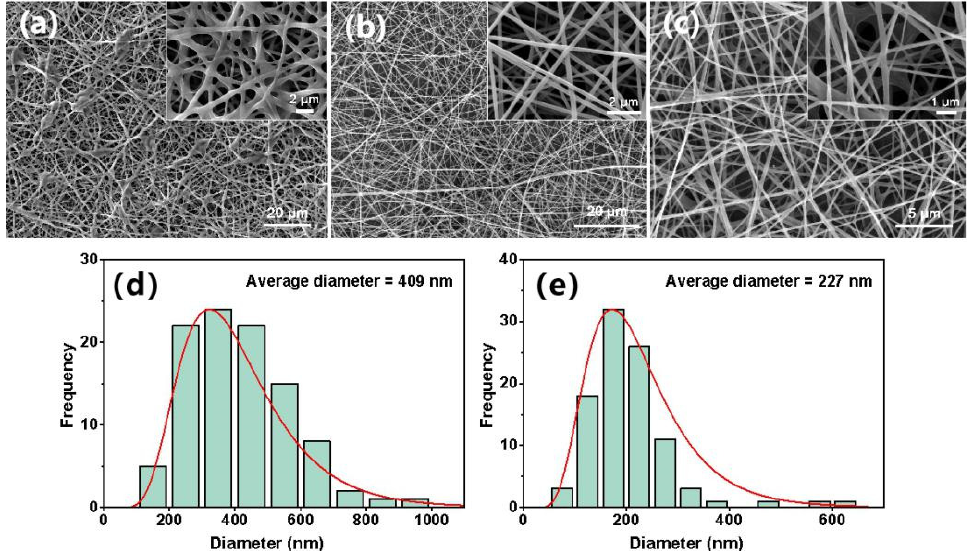
Figure 2. SEM images of F1 ( a ), F2 ( b ) and F3 ( c ) nanofibrous membranes. Diameter distributions of F1 ( d ) and F2 ( e ) nanofibers.